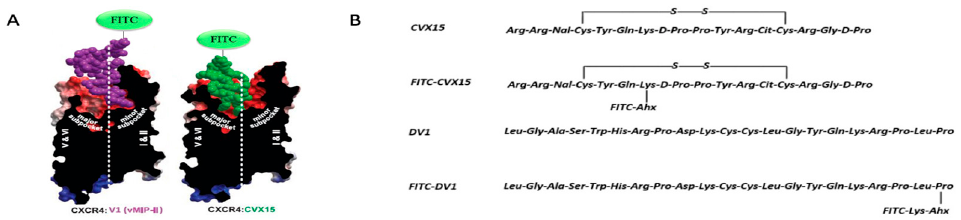
Figure 1. ( A ) Schematic diagrams of FITC-CVX15 and FITC-DV1 in complex with CXCR4 based on co-crystal structures. ( B ) Sequences and schematic structures of CVX15, FITC-CVX15, DV1 and FITC-DV1.